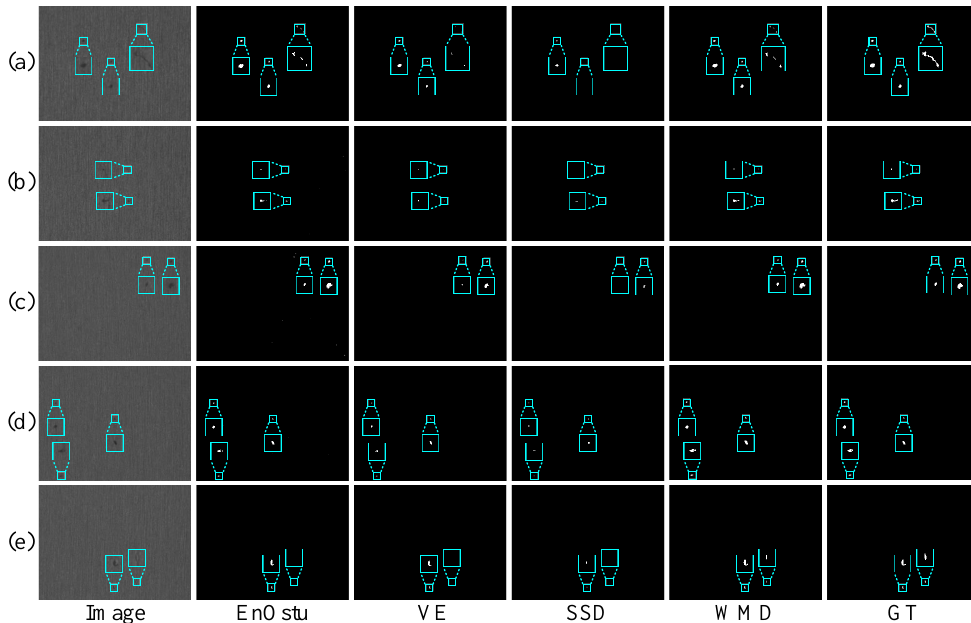
Figure 17. Visual comparisons of different methods on ( a – e ) five randomly selected multiple-defect images. Compared with the baseline methods, the proposed WMD produces more discriminative models, which is capable of identifying the defect from backgrounds.